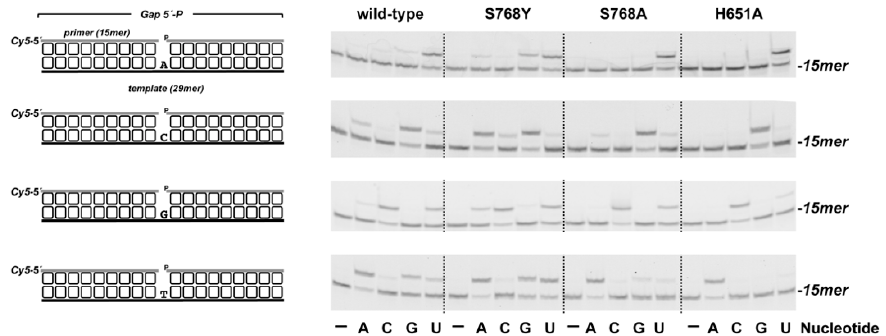
Figure 4. Nucleotide insertion fidelity by Pa -PolDom wild-type and mutants S768Y, S768A, and H651A at 1 nt gapped DNA. The four di ff erent 1 nt gapped structures used, di ff ering in the templating base are shown on the left. The assay was performed as described in Materials and Methods with 10 nM of the indicated substrate, 5 nM of either the wild-type or the specified Pa -PolDom mutant and 50 nM of the indicated NTP . Samples were incubated at 30 ◦ C for 3 min, products resolved by denaturing PAGE and further visualized using a Typhoon 9410 scanner (GE Healthcare).